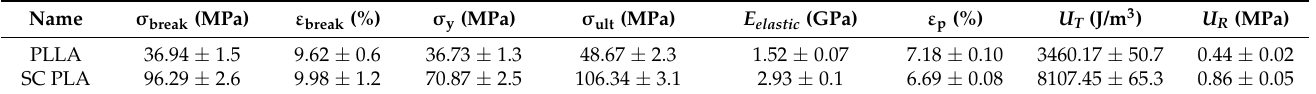
Table 4. The mechanical properties of injection molded neat PLLA vs. SC